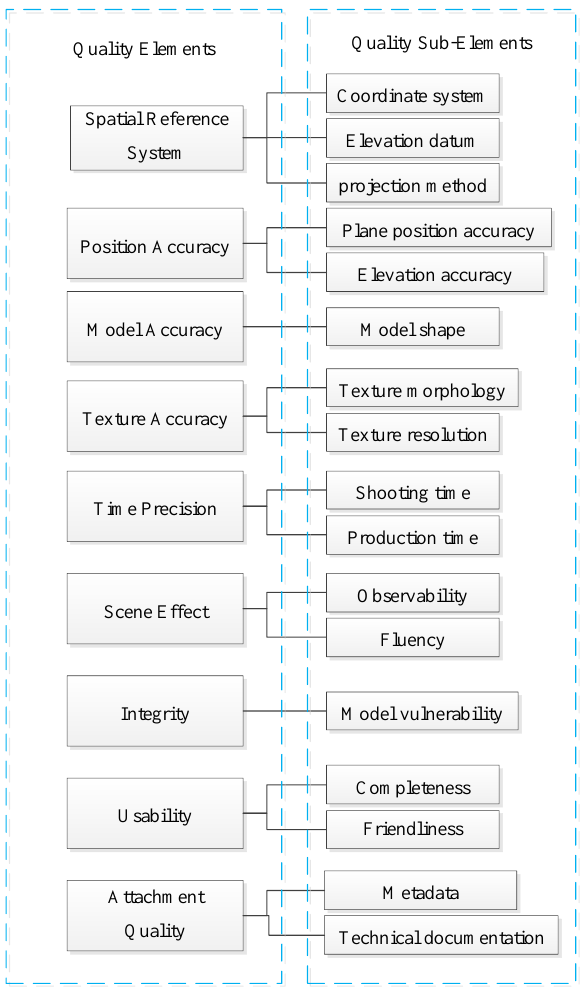
Figure 2. Real scene 3D model quality framework In the quality measurement of real scene 3D model, each quality element represents different aspects, so each quality element have different evaluation method. In quality measurement, evaluation methods should be used according to the characteristics of each quality element or quality sub element. In the quality element evaluation of real scene 3D model, the mean square error, correctness, rationality, reliability and standardization are mainly used for evaluation. The specific evaluation method of each quality element is shown in Figure